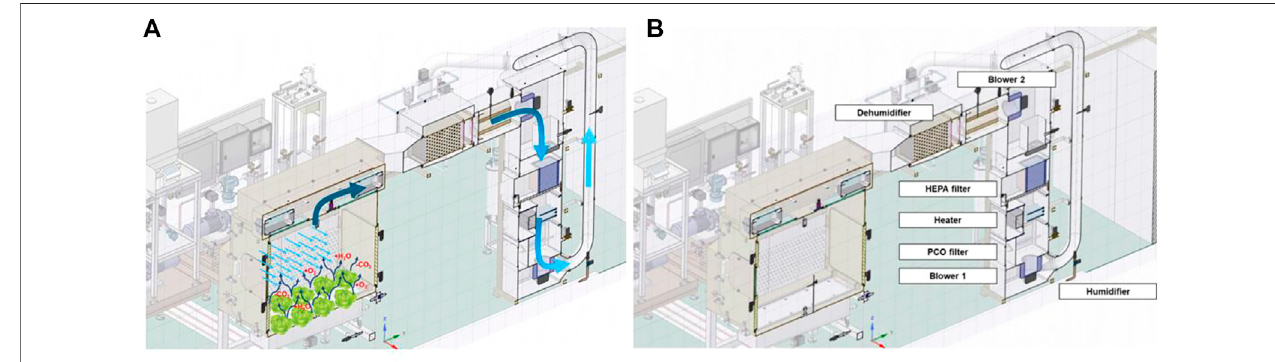
FIGURE 2 | Schematic view of the atmospheric system of the PCU: particular of the air fl ow from the plant chamber to the HVAC (A) and of the components position (B) .